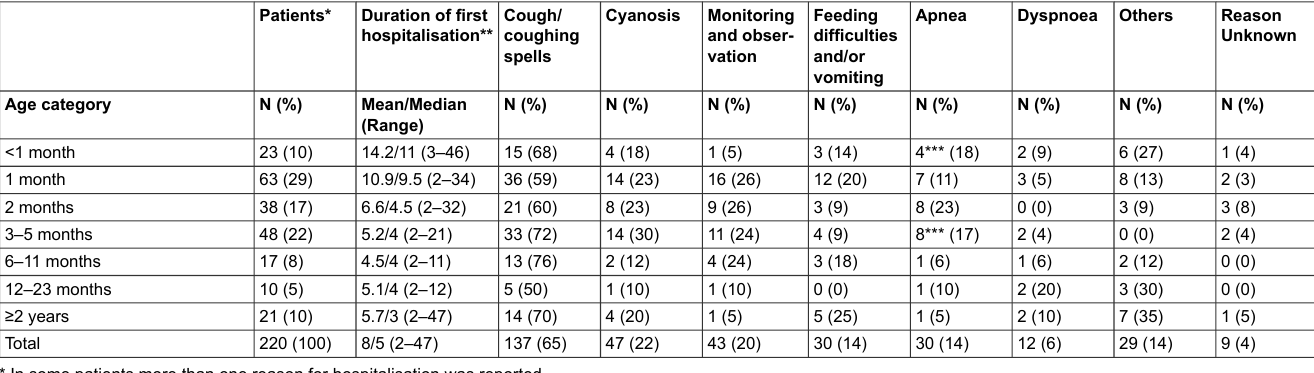
Table 2: Duration of and reasons for hospitalisation.